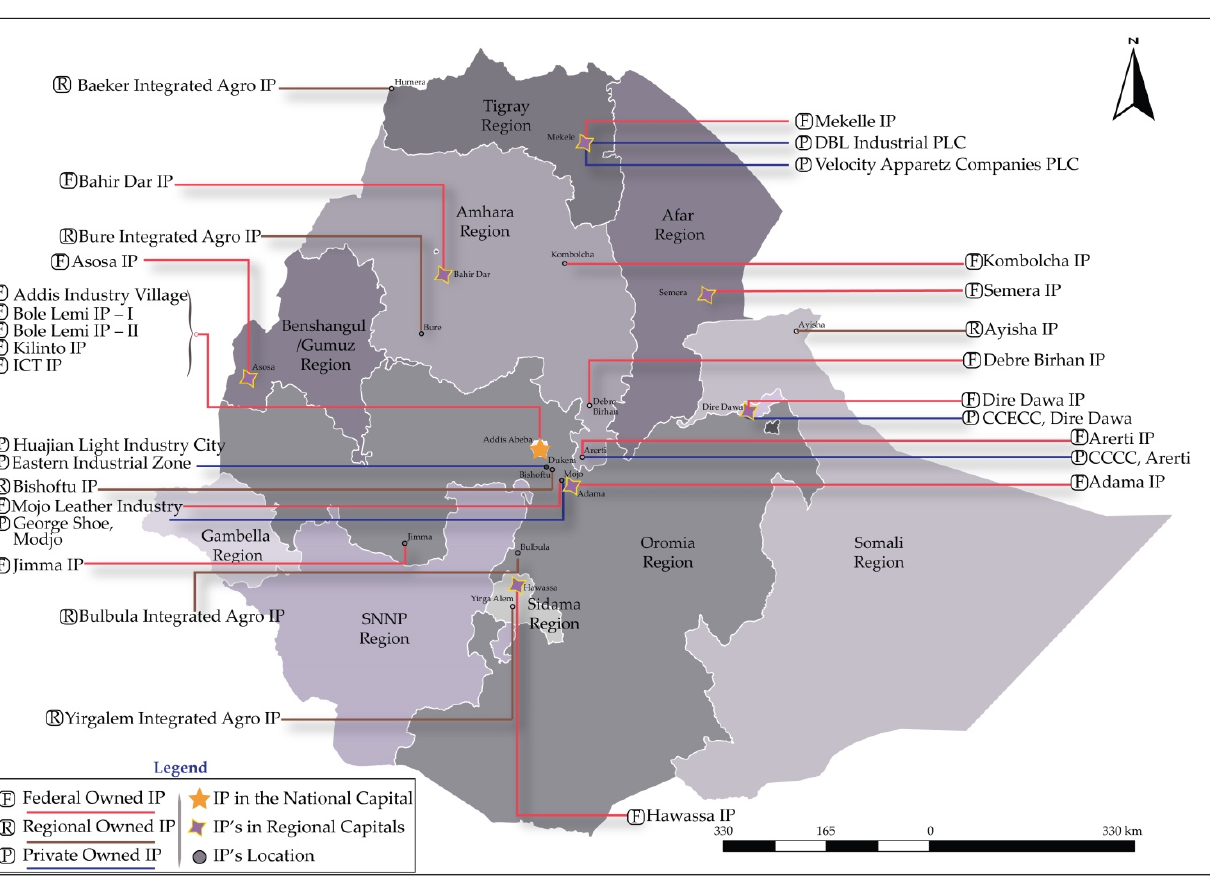
Figure 1. Industrial parks distribution map of Ethiopia; Source: EIC (2022). Computed by authors.